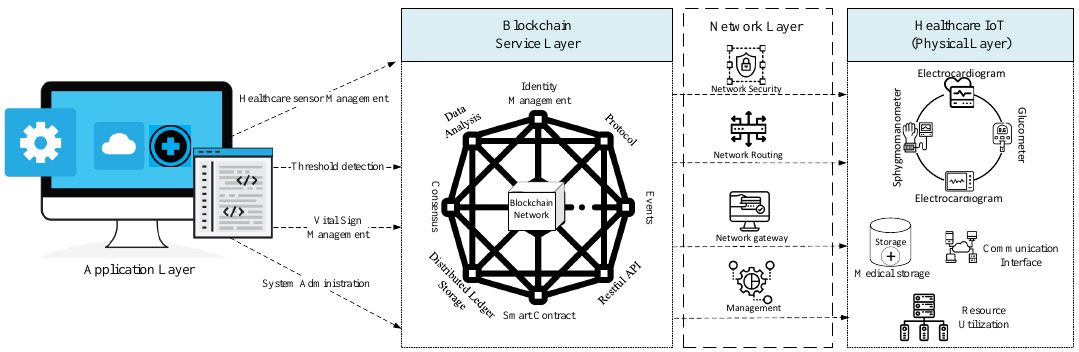
Figure 2. Proposed layered-based healthcare IoT blockchain platform architecture for secure vital-sign